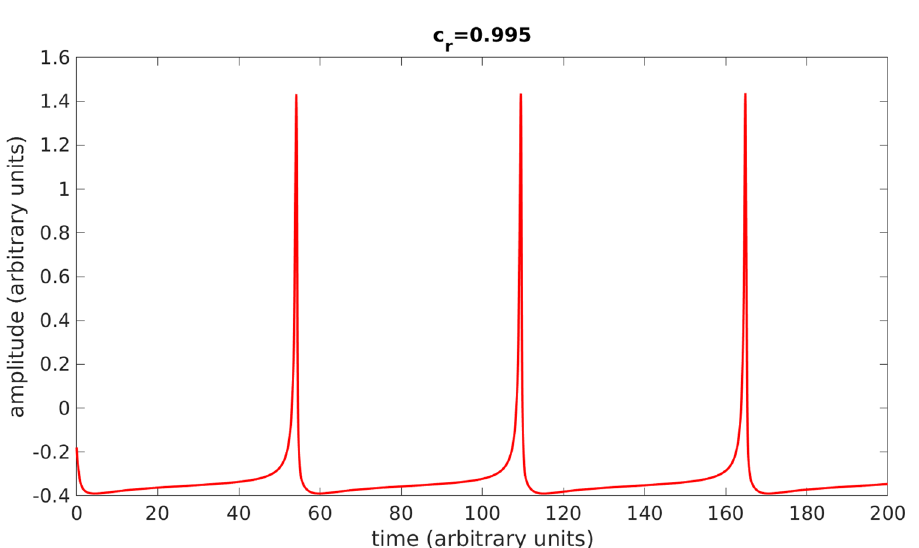
Figure 12. The amplitude and phase of a single mode for c r = 0.995